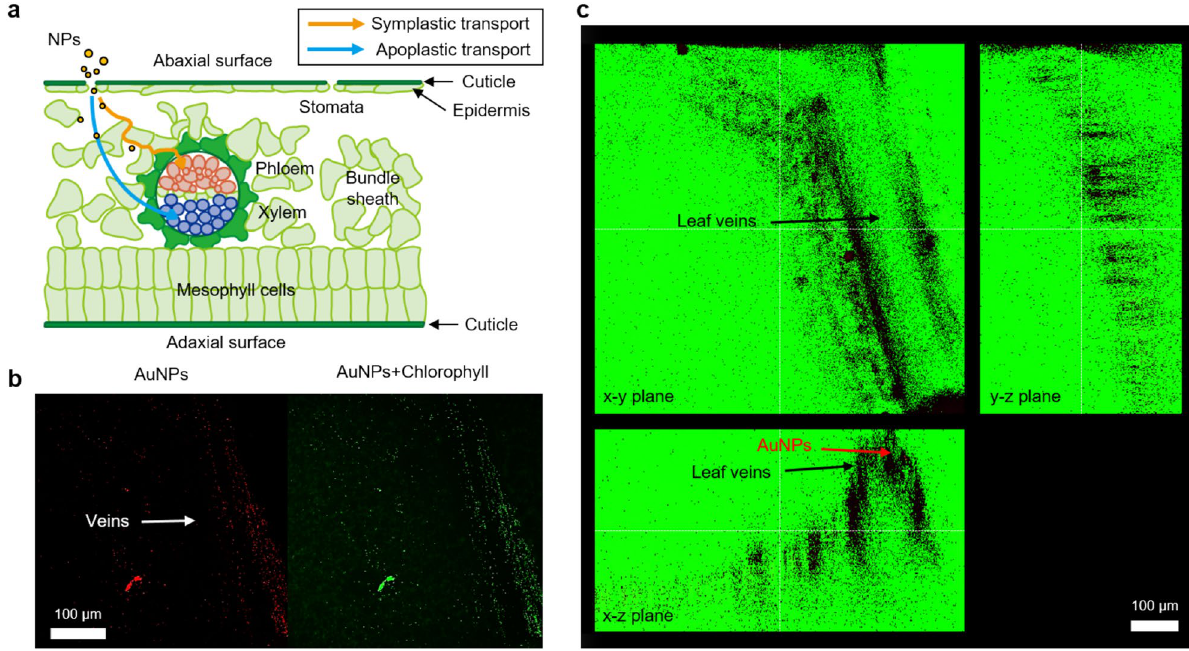
Figure 6. Translocation of the NPs absorbed through stomatal pathways. ( a ) Schematic showing the symplastic transport and apoplastic transport of NPs. ( b ) Accumulation of AuNPs near veins captured by TPEM imaging technique. Both images are projected in the depth direction to show the total distribution of AuNPs. White arrow indicates the position of leaf veins. ( c ) Color-filtered images showing the morphological features of leaf surface and 3D distribution of AuNPs. AuNPs are observed inside the veins, but they are not observed in the central region of vascular